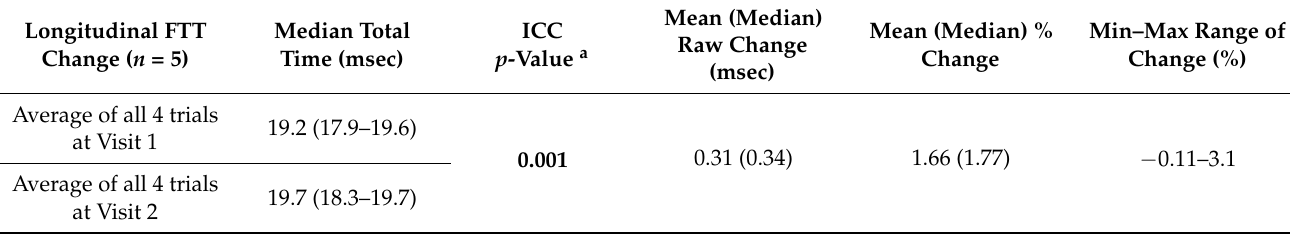
Legend: FTT—Fitts’ Tapping Task. Average FTT times are reported as median (interquartile range). PwMS— people with multiple sclerosis, ICC—interclass correlation coefficient, msec—milliseconds, Min—minimum,